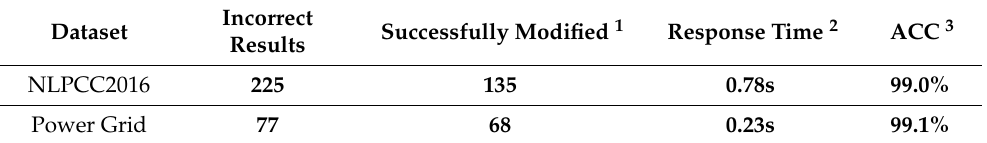
Table 8. Experimental results of the fuzzy matching module in the NLPCC2016 dataset and the power grid dataset. Incorrect Dataset Successfully Modified 1 Response Time 2 ACC 3 Results NLPCC2016 225 135 0.78s 99.0% Power Grid 77 68 0.23s